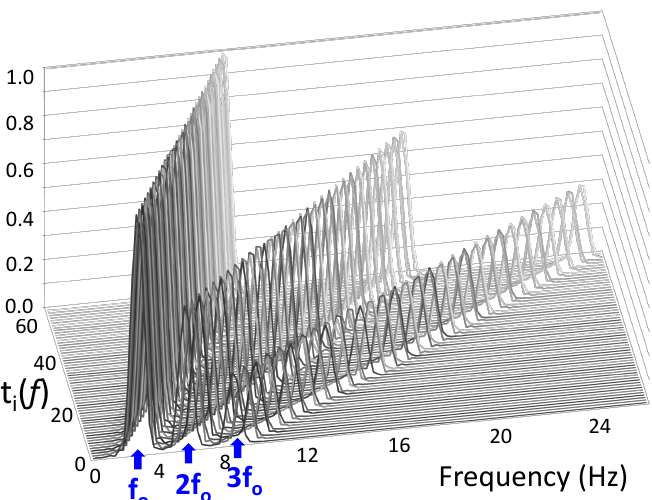
Figure 3. T ( f ) matrix. Rows are ideal tremor spectra, which each consist of a base frequency f 0 and two integer harmonics (2 f 0 and 3 f 0 ). Base frequencies are set every 0.1 Hz from 3–9